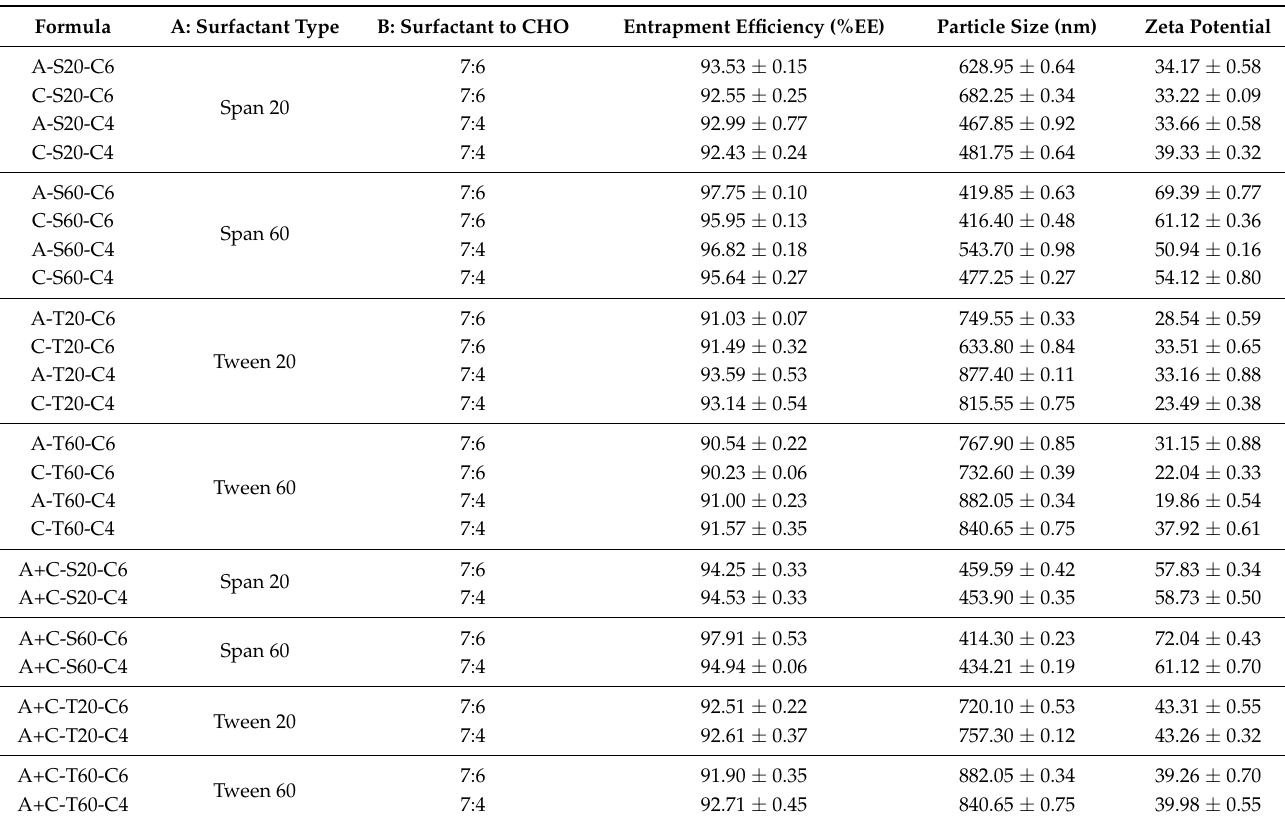
Table 3. Experimental runs, independent variables and measured responses, particle size, and zeta potential of acetazo- lamide and carvedilol niosomes formulae, n =